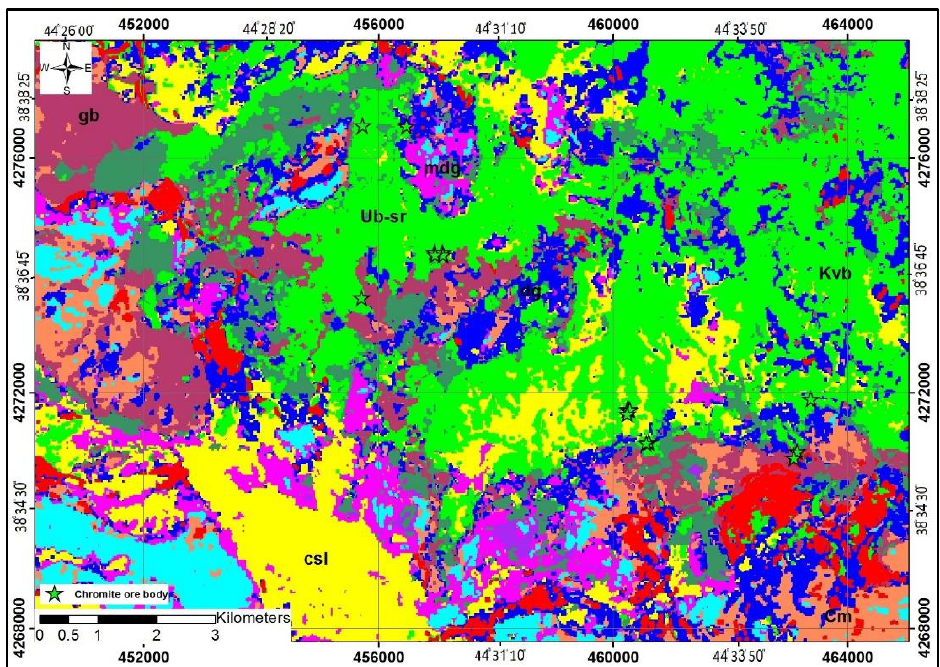
Figure 6. Classified map by using unsupervised classification method from pure pixels.